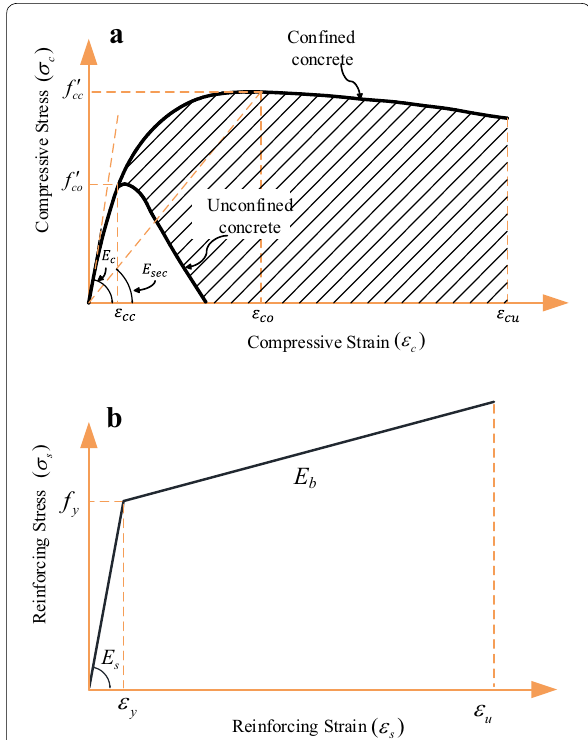
Fig. 2 a stress and strain relationship for concrete and b